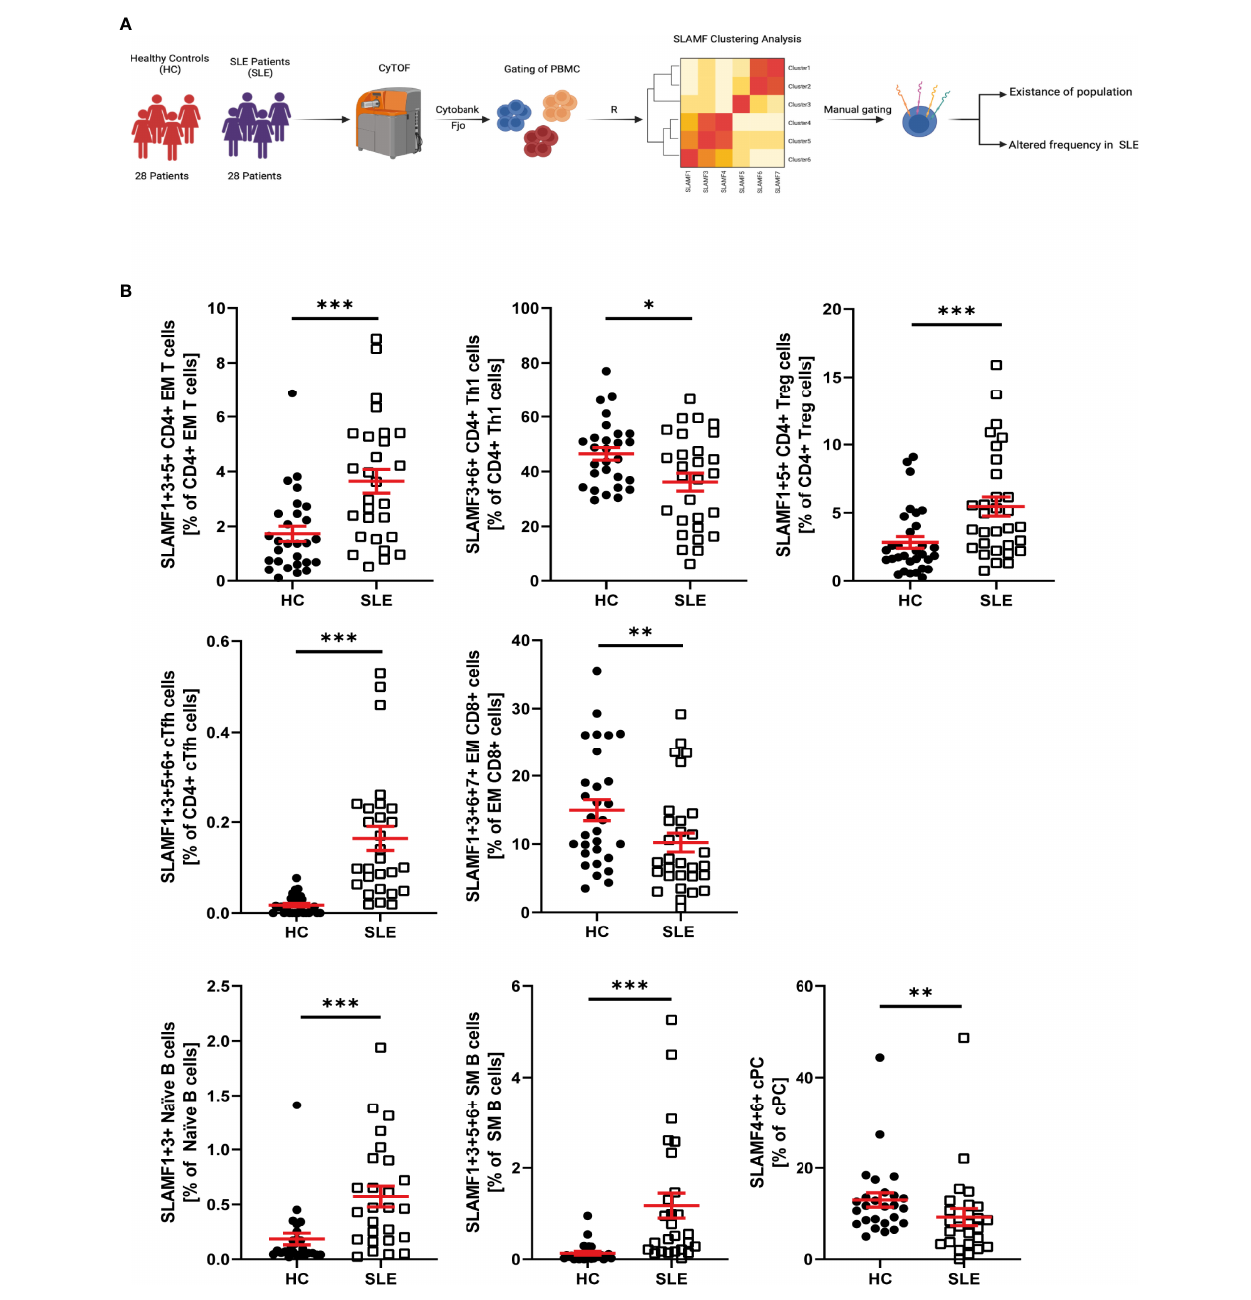
FIGURE 4 | SLAMF co-expressing PBMC in HC and SLE patients. (A) Graphical abstract of technical approach. (B) Frequency of SLAMF co-expressing populations identi fi ed by consensus clustering (T test on log10 transformed data, Welch ’ s T test if normal, Mann-Whitney if not normal distributed). Data represent mean ± SEM (*p = 0.02, **p = 0.02, ***p <